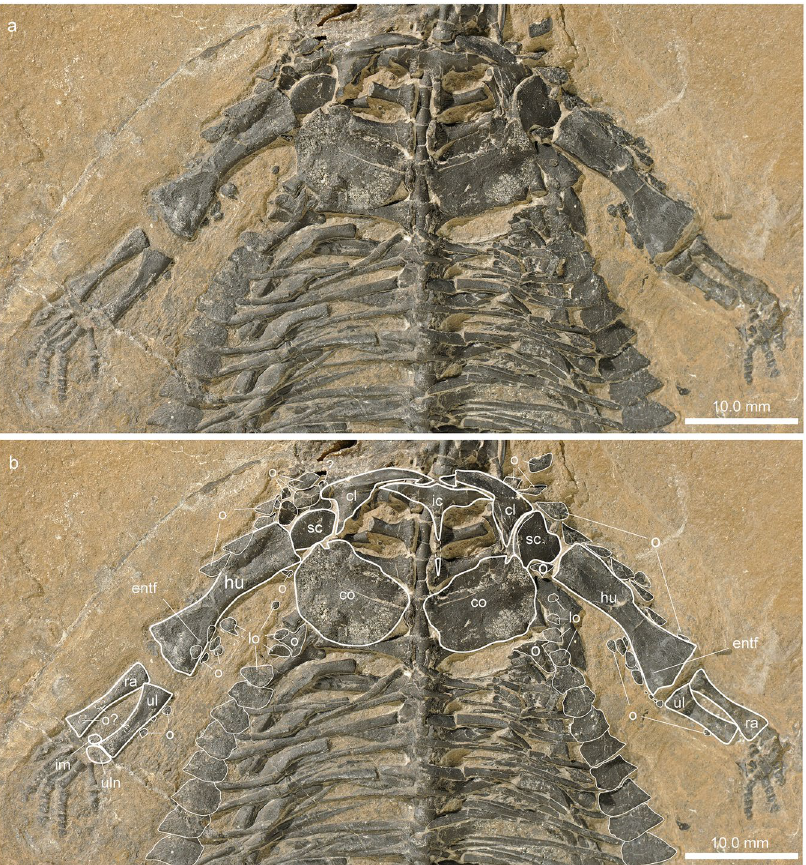
Figure 6. Pectoral and anterior thoracic region of Eusaurosphargis dalsassoi (PIMUZ A/III 4380). ( a ) Photograph. ( b ) Photograph overlain by interpretative drawing. Abbreviations used in the figure are clavicle (cl), coracoid (co), entepicondylar foramen (entf), humerus (hu), interclavicle (icl), intermedium (im), lateral osteoderm (lo), osteoderm (o), radius (ra), scapula (sc), ulna (ul), and ulnare